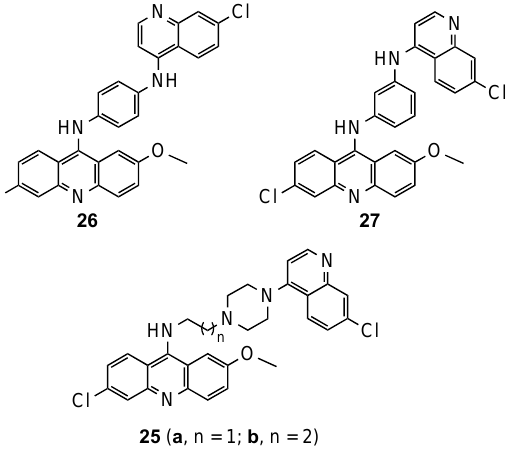
Figure 17. Quinoline – acridine hybrids 25 – 27 synthesized by Kumar and co-workers [38].